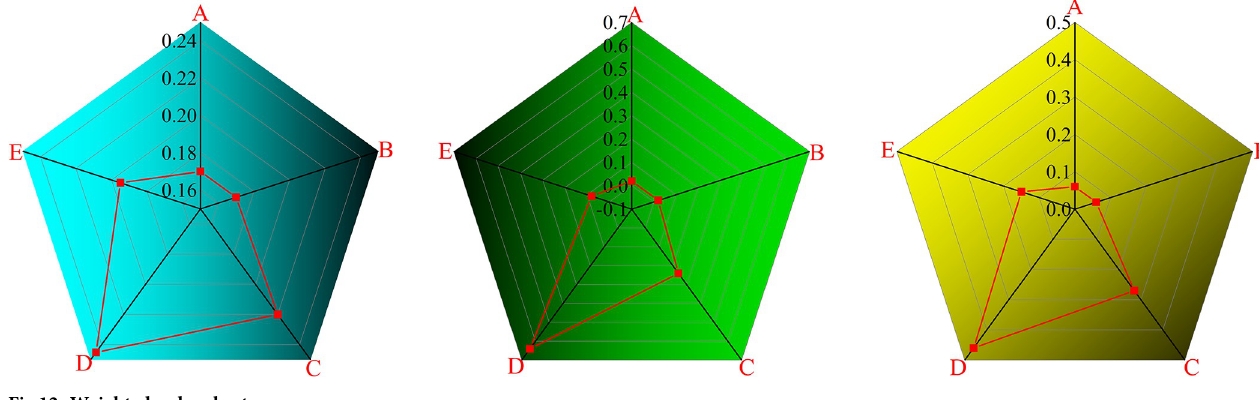
Fig 12. Weighted radar chart.